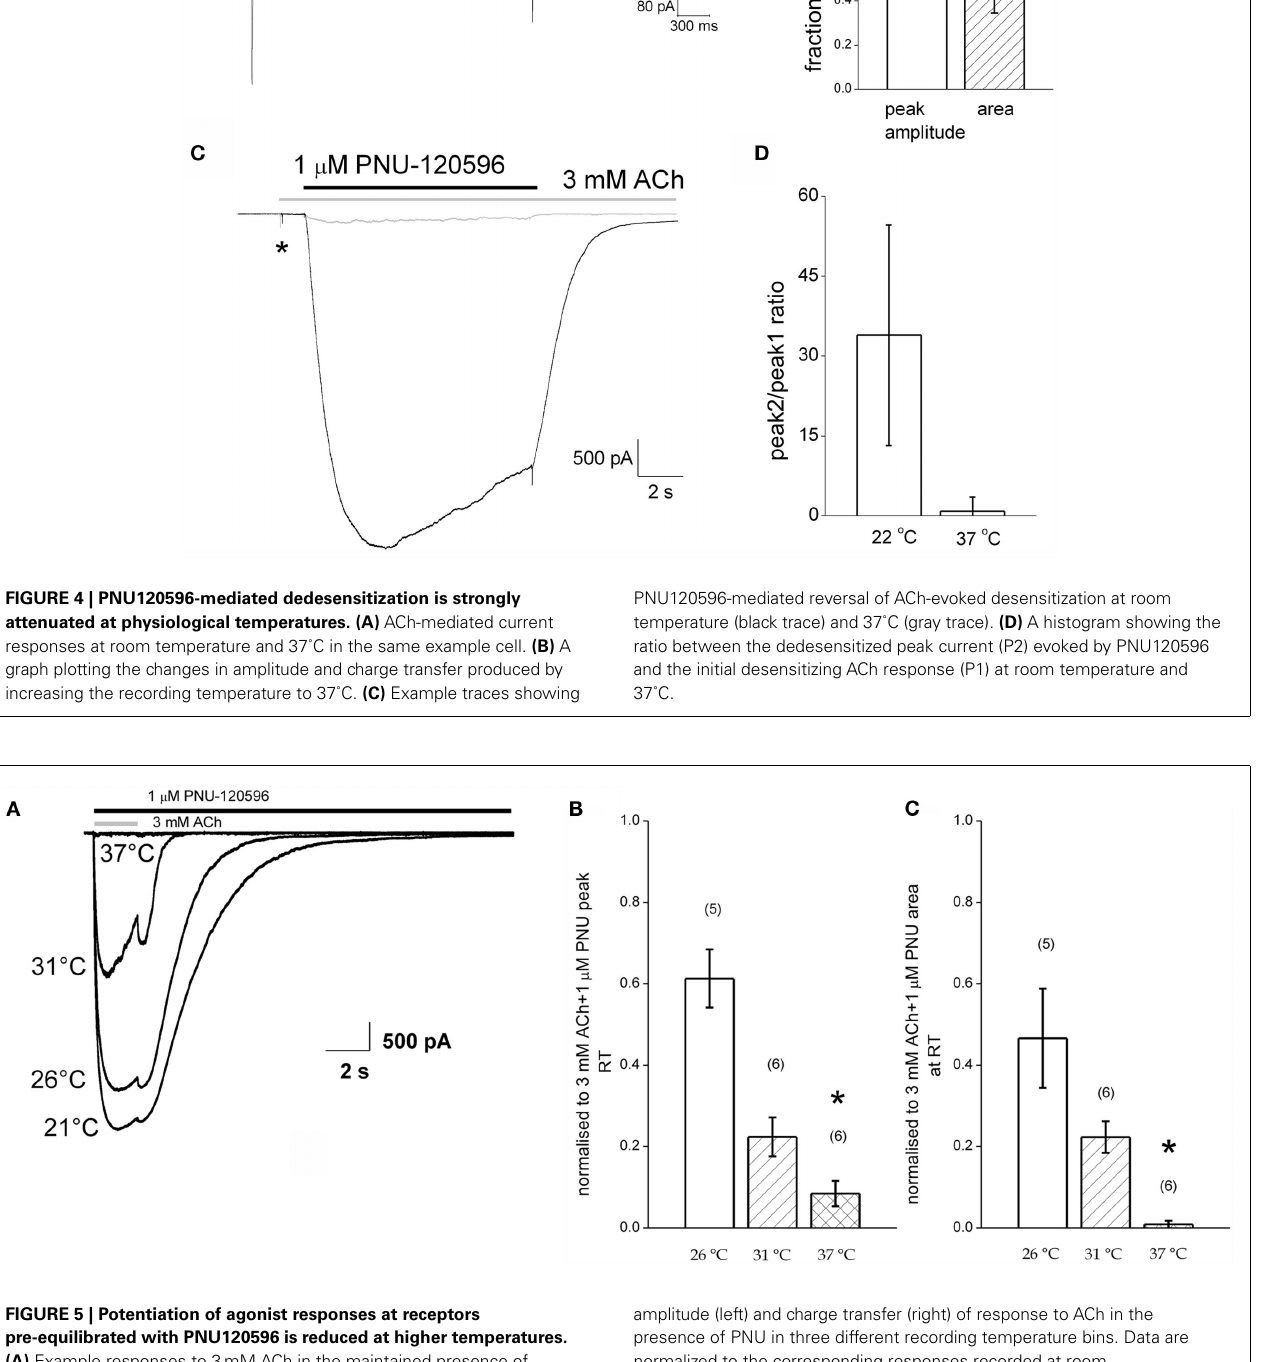
FIGURE 5 | Potentiation of agonist responses at receptors pre-equilibrated with PNU120596 is reduced at higher temperatures. (A) Example responses to 3mM ACh in the maintained presence of PNU120596 at four different temperatures. (B,C) Pooled data plotting the